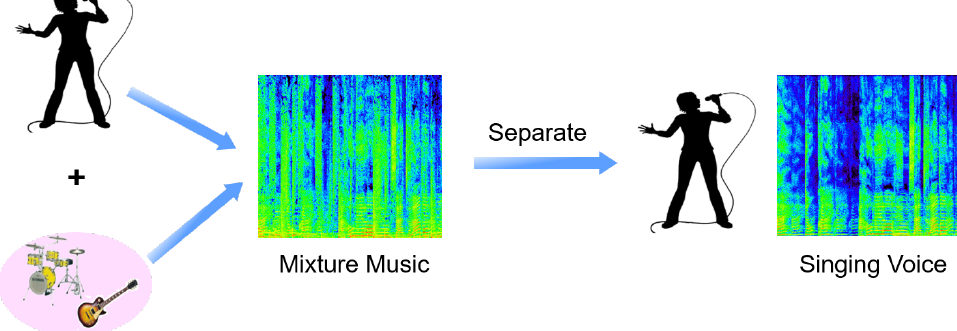
Figure 1. Blind monaural SVS